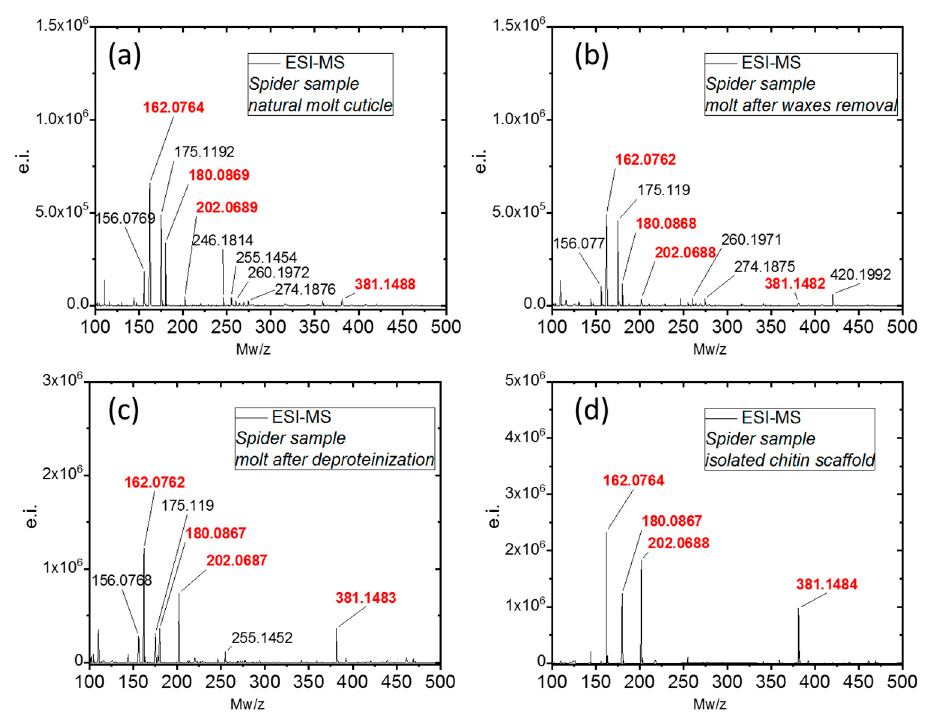
Figure 8. ESI-MS investigations of the chitin isolated from C. versicolor spider: ( a ) natural molt cuticle; ( b ) molt after wax removal; ( c ) molt after deproteinization; ( d ) isolated chitin scaffold.